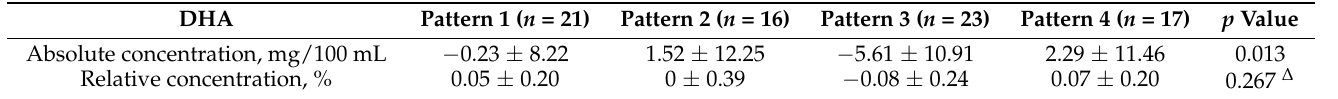
Table 5. Changes in DHA concentrations of breast milk with respect to dietary patterns in the supplement group.